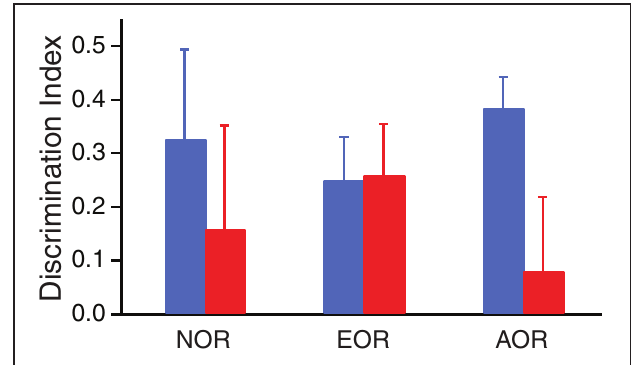
FIGURE 3 | Differential exploration of novel vs. familiar items in the three tasks. The bar graph illustrates the discrimination index of Resilient (blue) and PTSD-like (red) rats in the three tasks (NOR, left; EOR, middle; AOR, right). To compute the discrimination indices, we used exploration times during the first 1.5min of the test